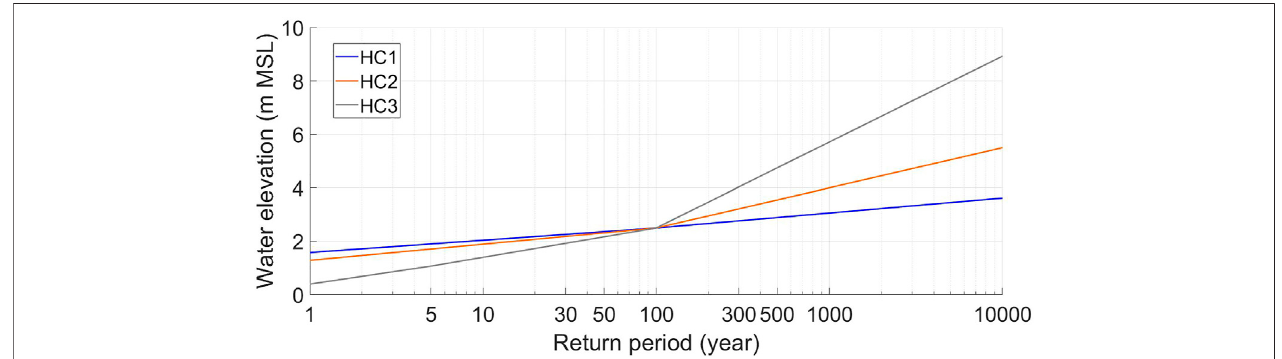
FIGURE 3 | Water level vs. return period curves for the three idealized hazard